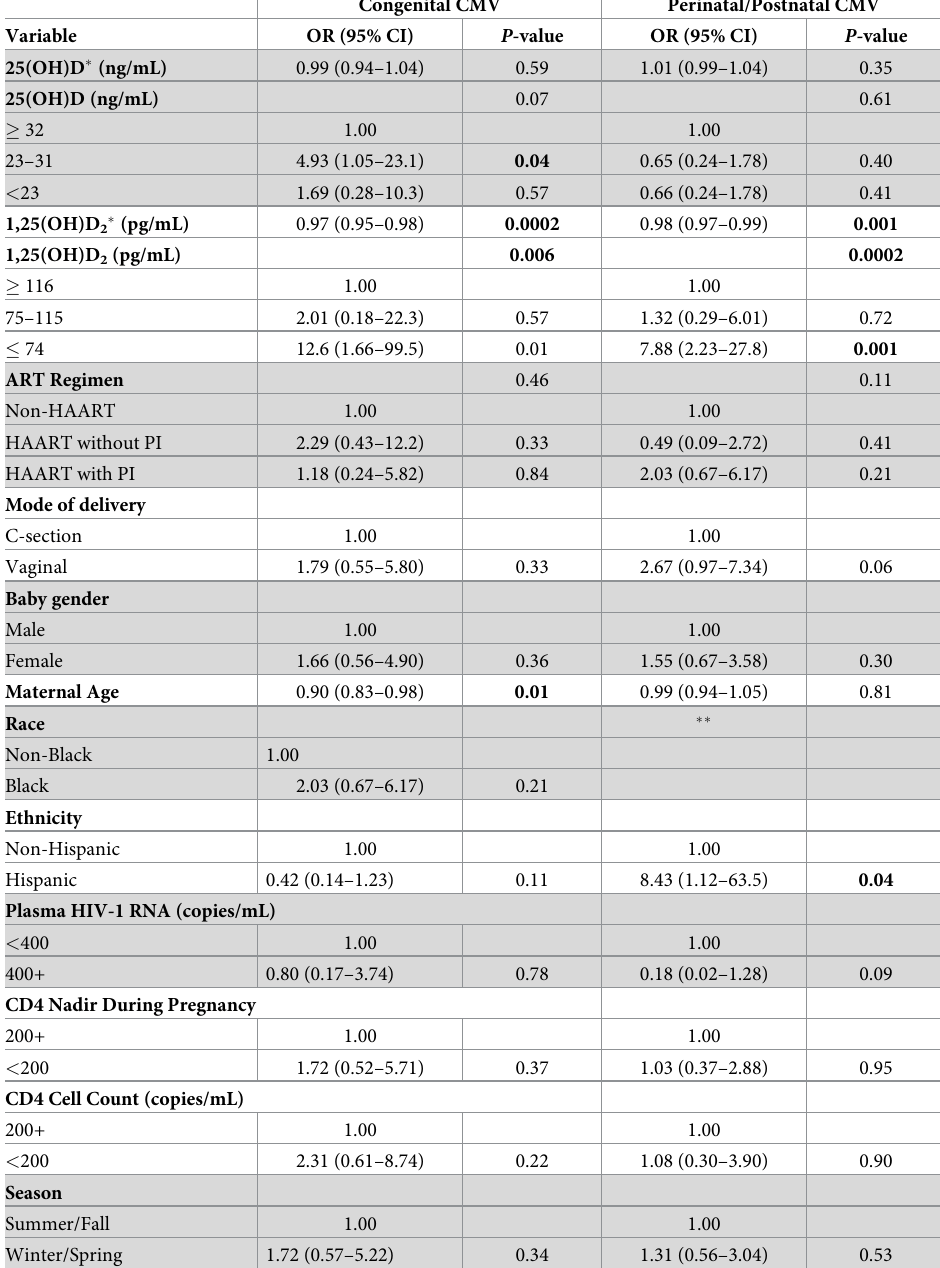
Table 3. Factors univariately associated with congenital and perinatal/postnatal CMV